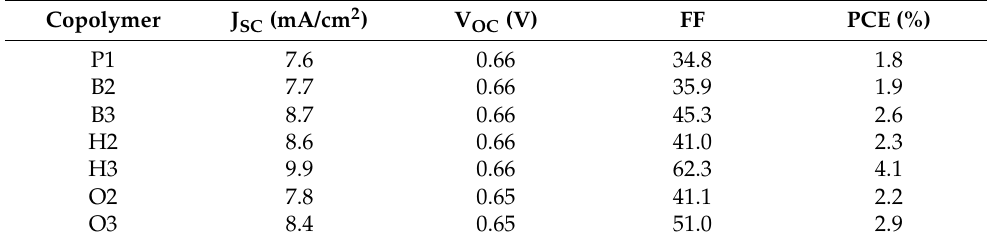
Figure 7. J–V curves of used solar cells of ( A ) B2, B2, ( B ) H2, H3, and ( C ) O2, O3. All figures are presented with the J–V of P1 for better comparison.; dash lines for before annealing and straight lines for after annealing. Table 3. Parameters of used BHJ type devices after annealing.